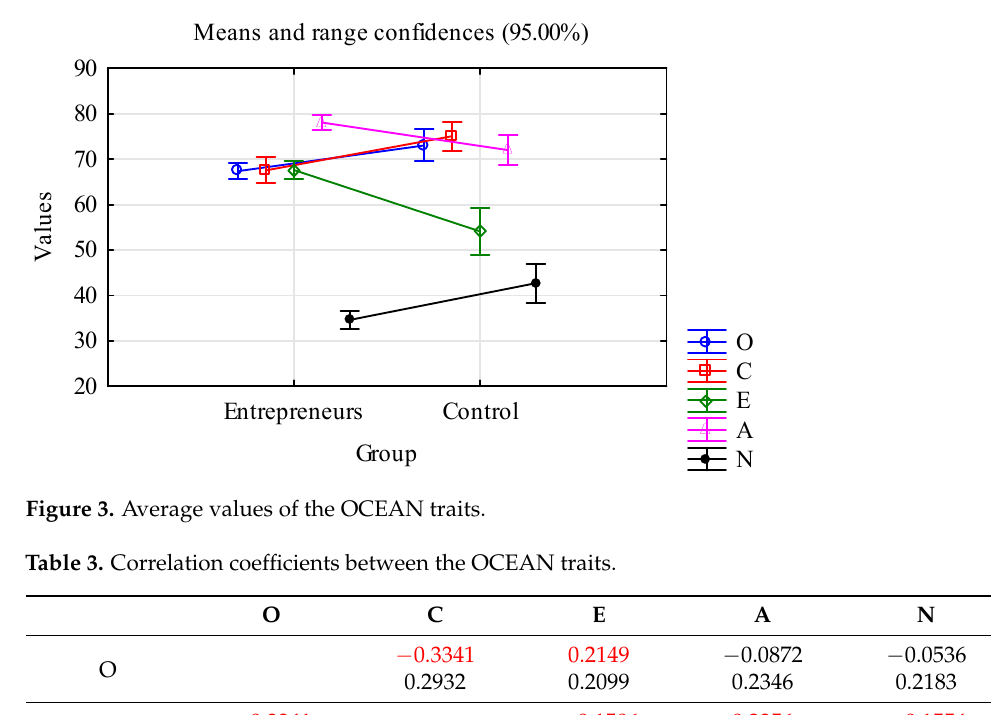
Table 3. Correlation coefficients between the OCEAN traits.